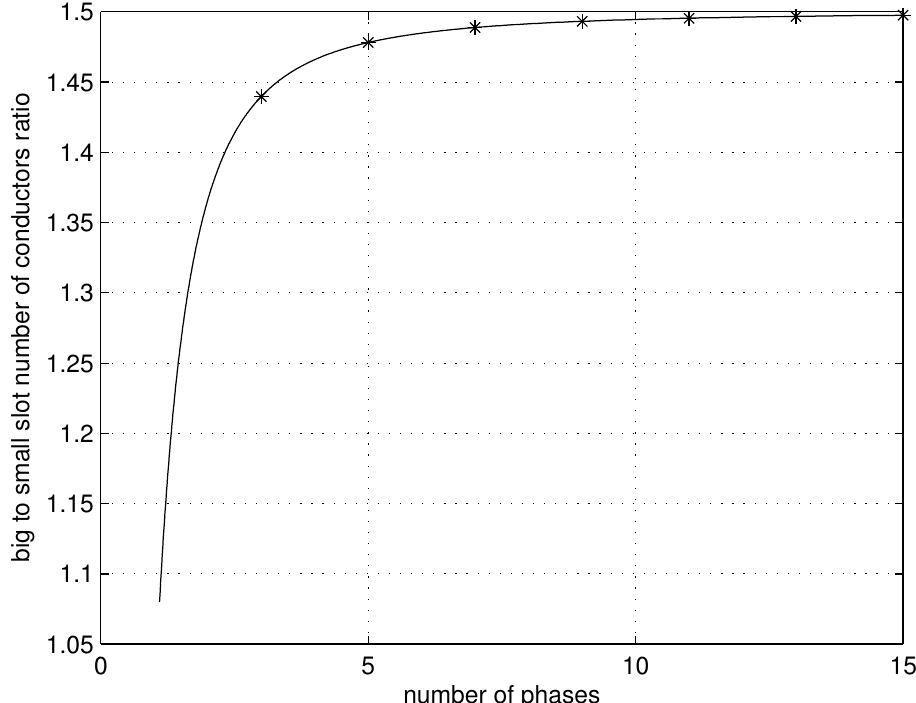
Figure 9. Big to small slot number of conductors ratio